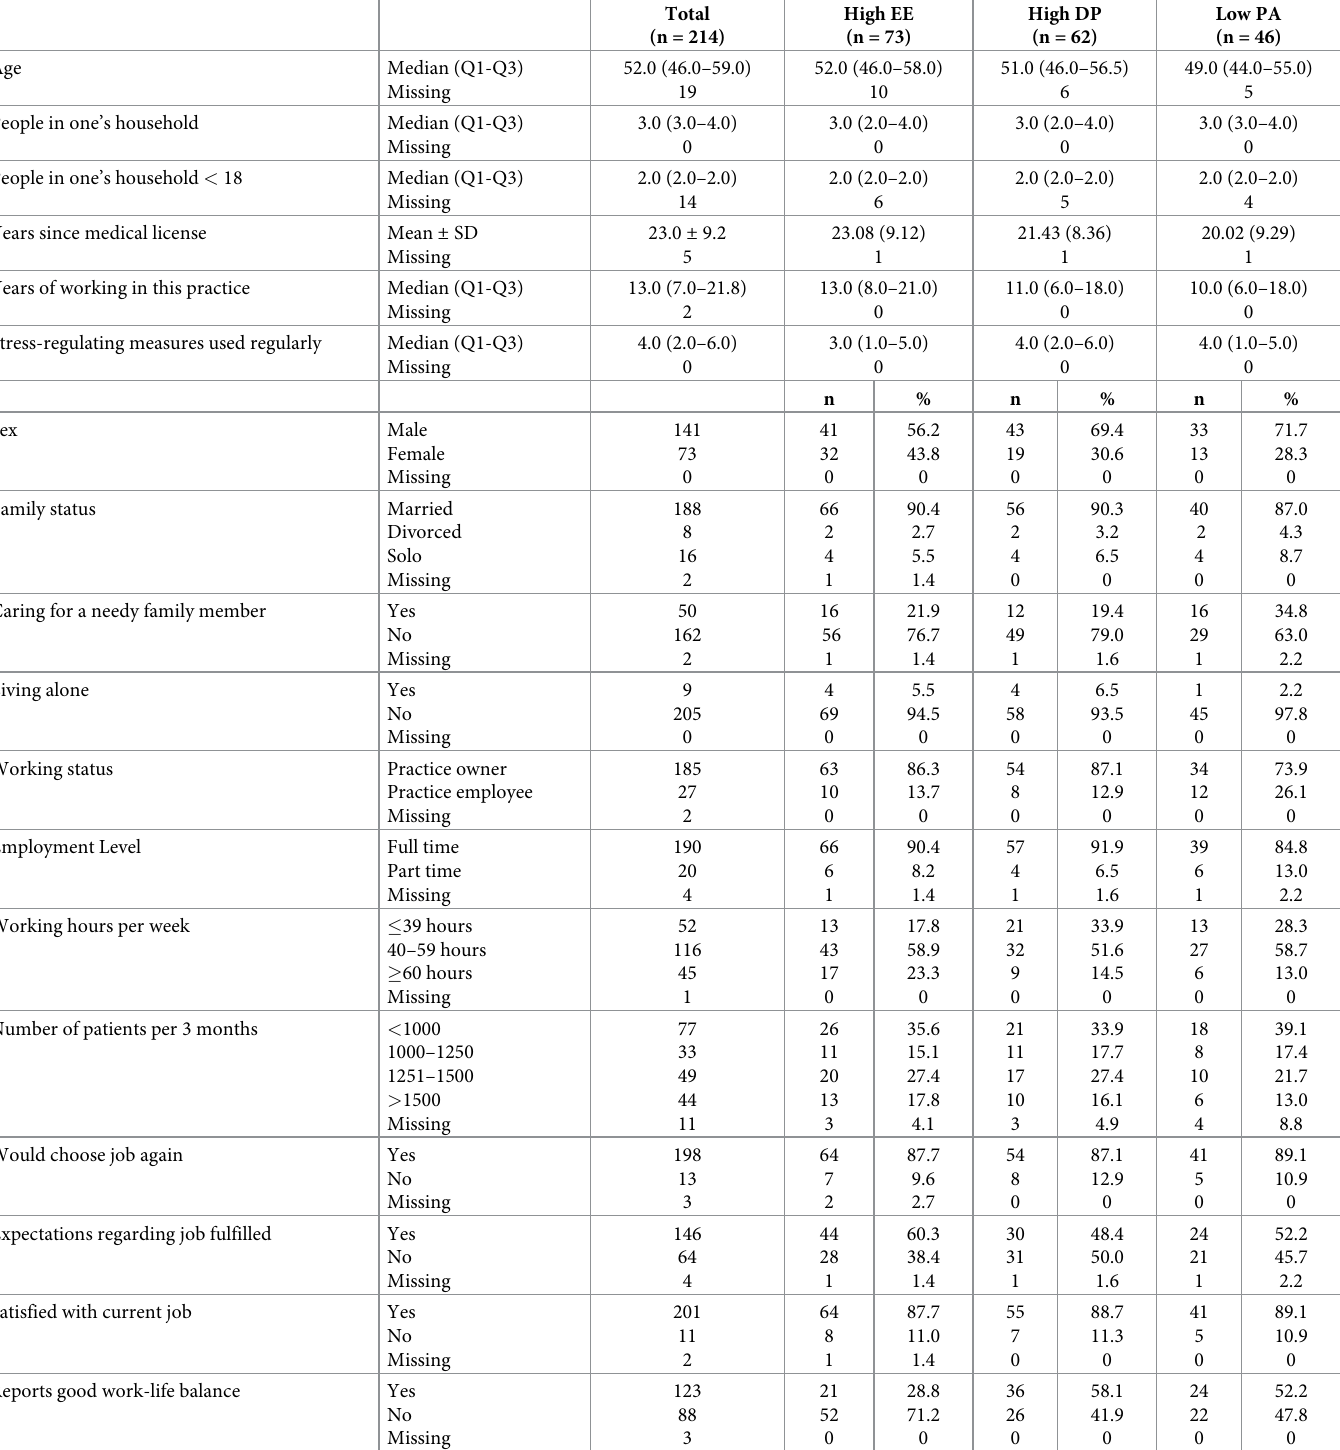
Table 2. Socio-demographic and job-related characteristics of the participating physicians (n = 214) stratified by the three burnout dimensions high emotional exhaustion (EE), high depersonalization (DP) and low personal accomplishment